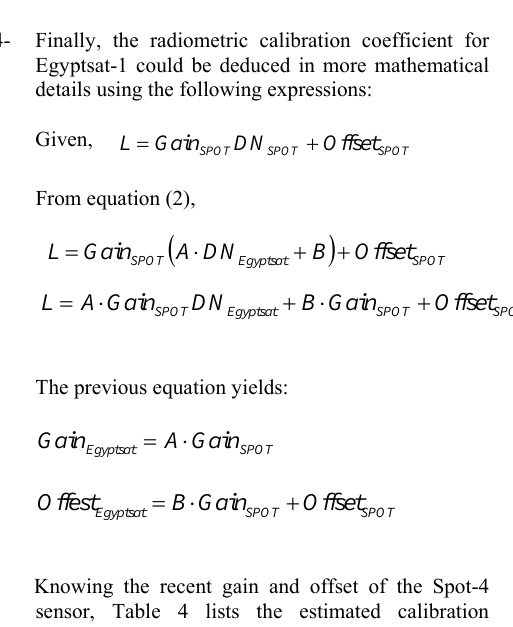
Figure 2. Scatter plot of SPOT-4 and Egyptsat-1 DN’s for the first band